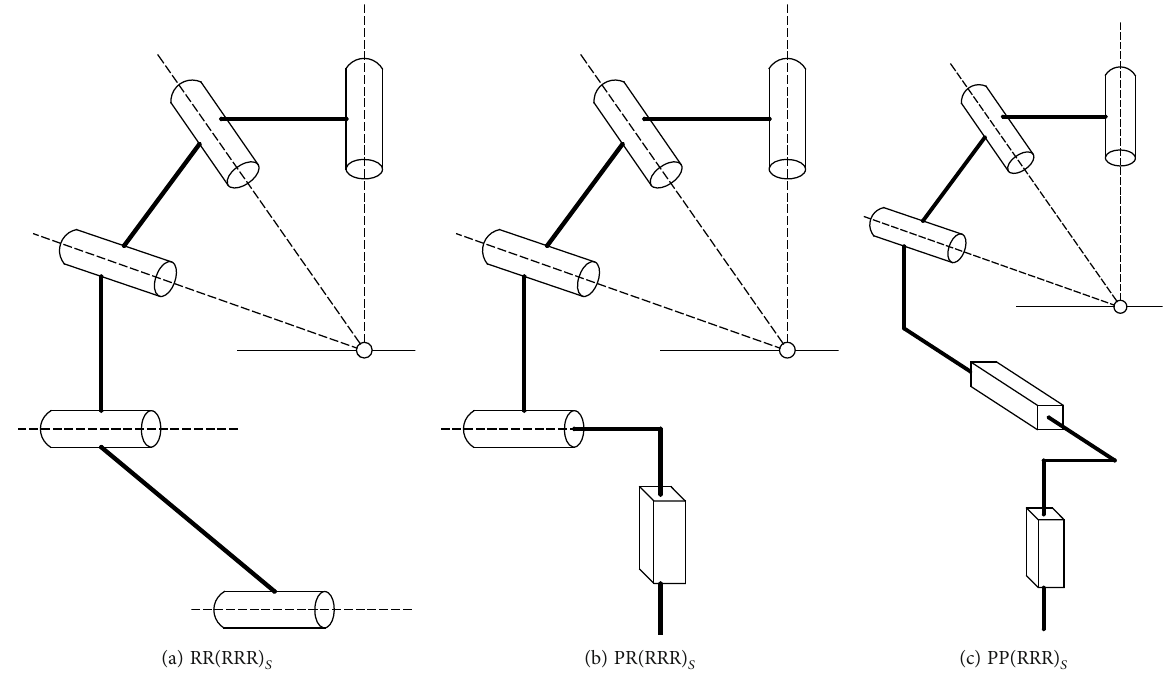
Figure 11: Kinematic units by combining with rotation pairs and moving